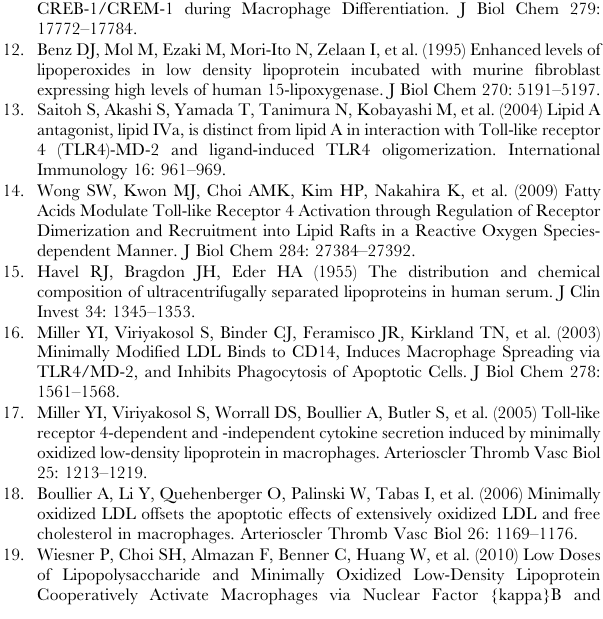
Figure S5 mmLDL-induced phosphorylation of ERK1/2 in WT and MyD88 2 / 2 macrophages. WT and MyD88 2 / 2 BMDM (mouse genotypes have been confirmed with PCR) were incubated with media or mmLDL (50 m g/ml) for 15 min. Cell lysates were separated on SDS-PAGE and immunoblotted with antibodies against phospho-ERK1/2 and